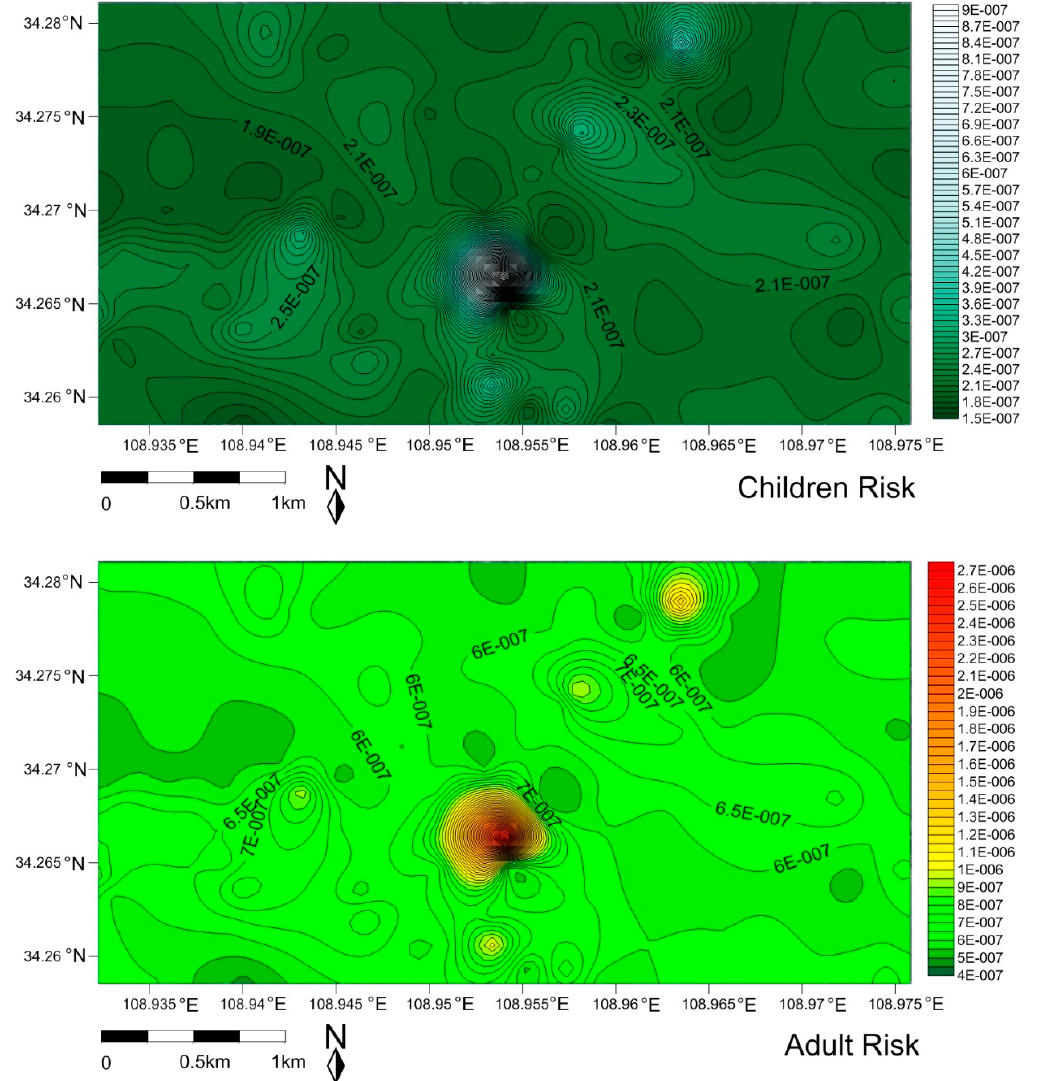
Figure 7. The spatial risk of total carcinogenic for children and adult exposure to the traffic-related multi-trace metals / metalloids in street